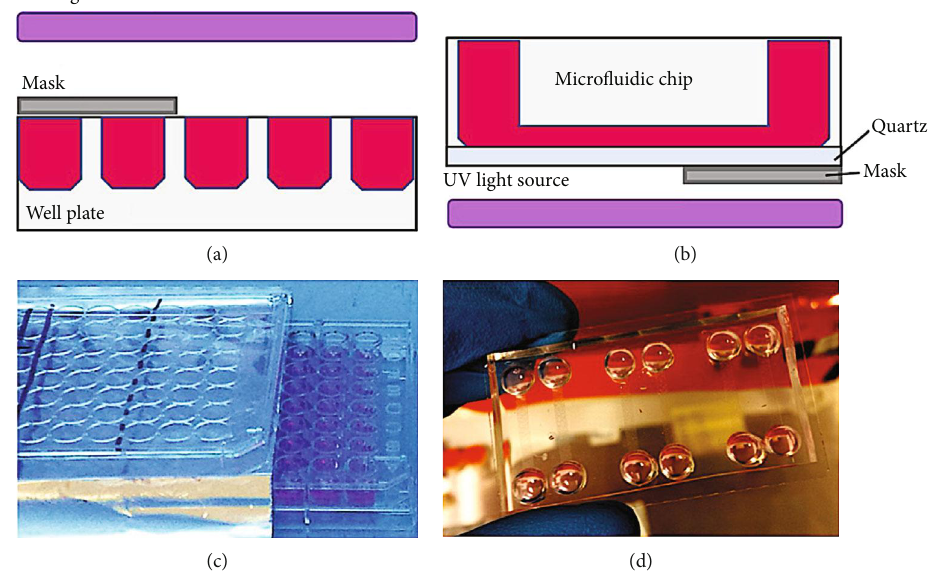
Figure 24: Diagram of di ff erent UV exposure methods, with (a) top-down UV from the biosafety cabinet on a 96-well plate and (b) bottom-up UV from the light table on a micro fl uidic chip. Photographs of (c) well plate and (d) micro fl uidic device. Reproduced (or adapted) with permission [121], ©2019, American Institute of Physics.